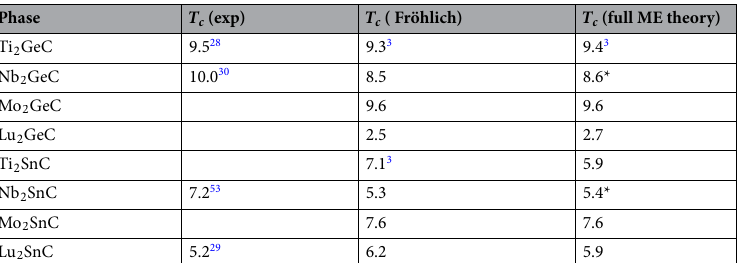
Table 1. Superconducting temperature values ( T c in K) for M 2 AC (M:Ti, Nb, Mo and Lu, A: Ge and Sn) in experiment, predicted using the Fröhlich model and calculated by Migdal–Eliashberg (ME) theory (with µ ∗ 0.13). *This value was calculated with µ ∗ 0.13 whilst the corresponding value in ref. 2 had µ ∗ =